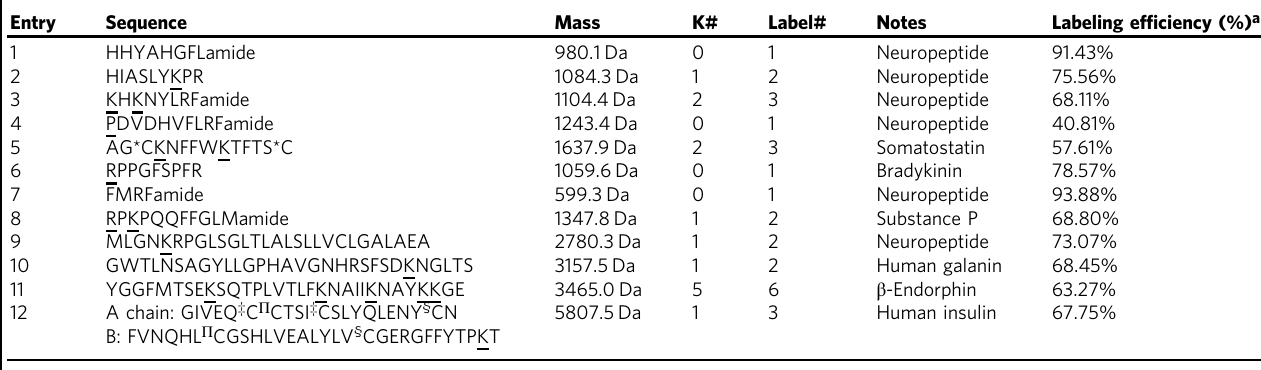
Table 1 Highly ef fi cient peptide/small protein labeling via